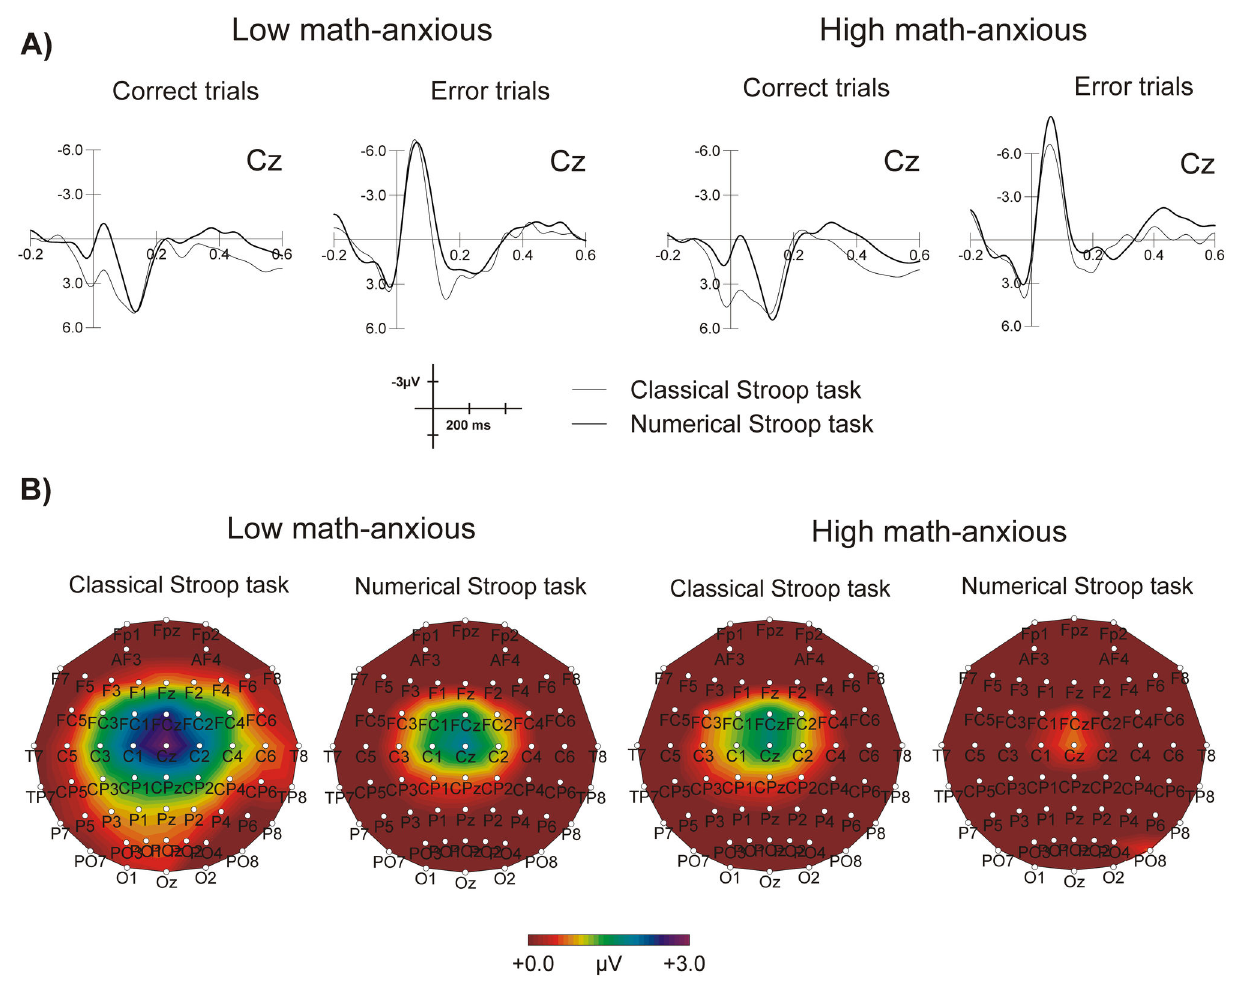
Figure 4. Image of error-related brain potentials. Grand average waveforms at Cz for the Pe component after errors and correct responses for the LMA and the HMA groups in the numerical and the classical Stroop tasks (A) and scalp topography of the Pe component after errors in the 150-250 ms window for the LMA and the HMA groups in the classical and numerical Stroop tasks (B). doi: